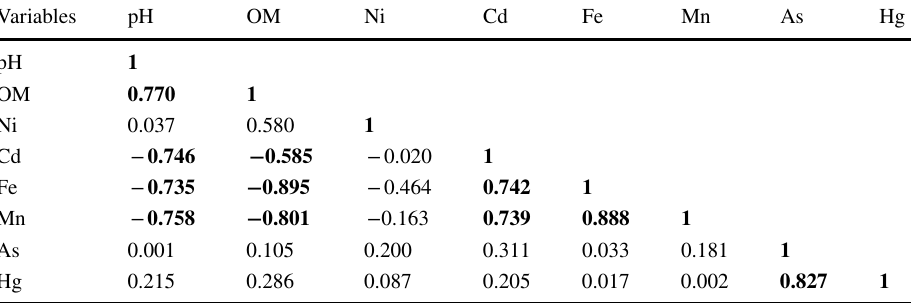
between parameters analyzed in sediments